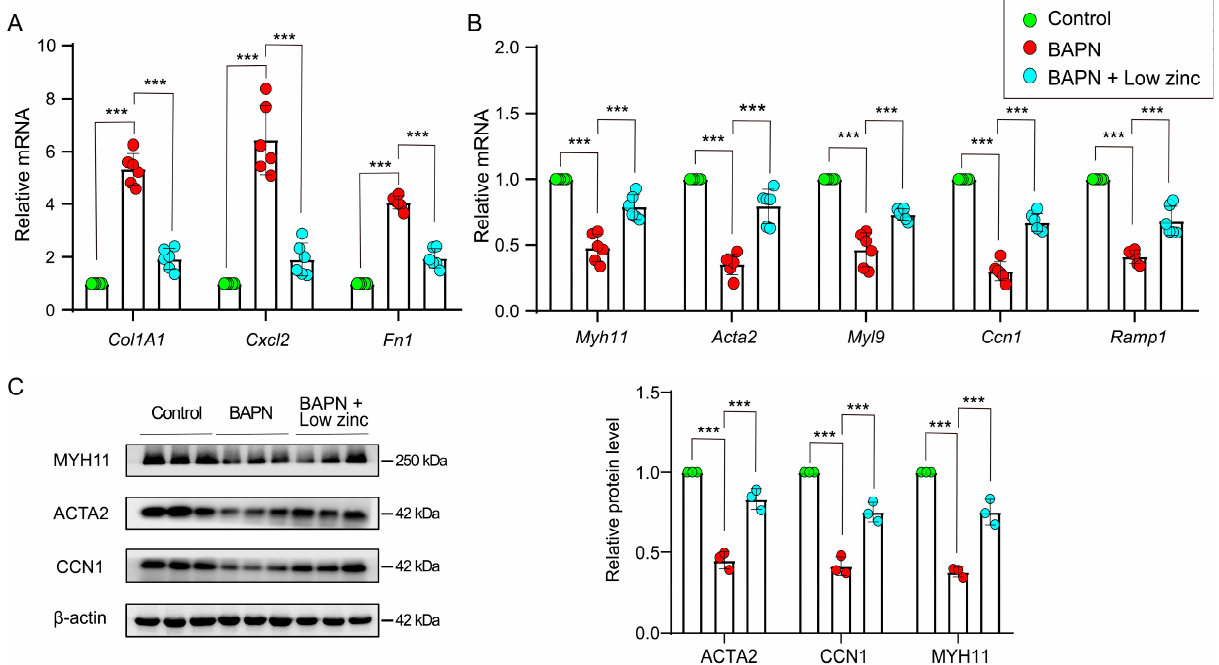
Figure 4. Low zinc suppressed the phenotype switch of vascular smooth muscle cells. ( A ) Relative mRNA levels of selected VSMC synthetic genes ( Col1A1 , Cxcl2 and Fn1 ) in mice aorta ( n = 6 per group); by two-way ANOVA (*** p < 0.001). ( B ) Relative mRNA levels of selected VSMC contractile genes ( Myh11 , Acta2 , Myl9 , Ccn1 and Ramp1 ) in mice aorta ( n = 6 per group); by two-way ANOVA (*** p < 0.001). ( C ) The protein levels (left column is western blot result, right column is quantitative analysis) of selected VSMC contractile markers (MYH11, ACTA2 and CCN1) in mice aorta ( n = 3 per group); by two-way ANOVA (*** p < 0.001). All samples were collected after the animal experiment ended (BAPN-induced 30 days).